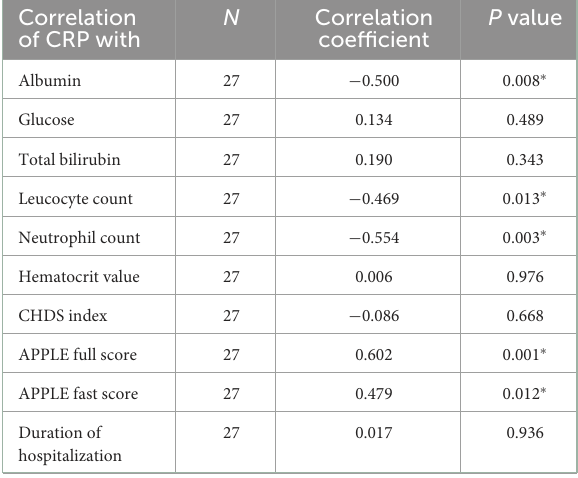
TABLE 2 Spearman correlation of C-reactive protein (CRP) with laboratory variables and clinical scores of 27 dogs with